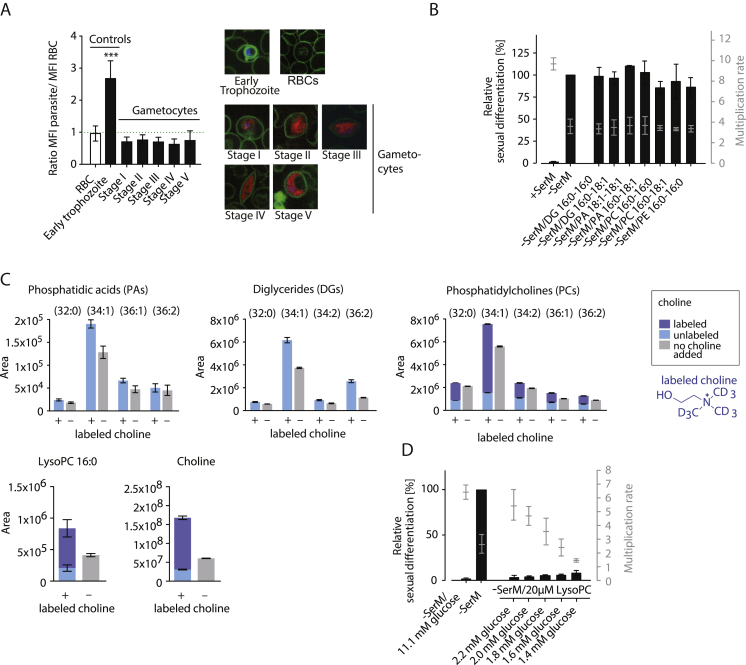
Related to Figures 2 and 3(A) Live cell microscopy comparing uptake of TopFluor-labeled LysoPC between P. falciparum gametocytes and asexual parasites. LysoPC uptake in the parasite is quantified relative to accumulation at the erythrocyte surface (left panel). 100 cells were analyzed per stage. Representative pictures are shown (right panel). Standard deviations are shown, (∗∗∗p < 0.001, Student’s t test).(B) Increase of exogenous supply of Kennedy pathway metabolites does not affect P. falciparum parasite sexual differentiation. DG, diglycerides; PA, phosphatidic acids; PC, phosphatidylcholines; PE, phosphatidylethanolamine. n = 3, standard deviations are shown.(C) Levels of parasite phosphatidic acids (PAs), diglycerides (DGs), phosphatidylcholines (PCs), LysoPC(16:0) and choline are significantly increased in the presence of a high concentration of choline. Bars show chromatographic areas under the curve. Colors indicate the contribution of labeled and unlabeled molecules to the total peak areas. n = 3, standard errors of the means are shown.(D) Glucose levels have no autonomous effect on parasite sexual differentiation. While glucose can prevent sexual differentiation in absence of LysoPC (see Figure 3F), limiting levels of this sugar do not induce gametocyte formation under LysoPC-rich conditions. n = 3, standard deviations are shown.